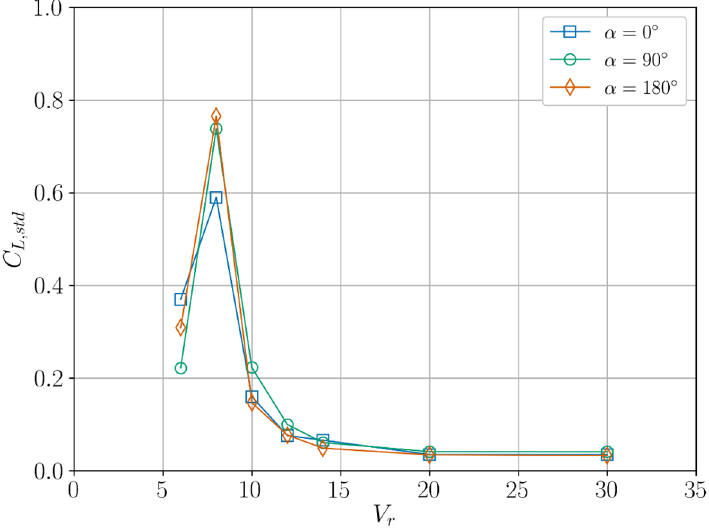
Figure 14. Standard deviation of transverse force coefficient of FOWT platform under different current incidence conditions.